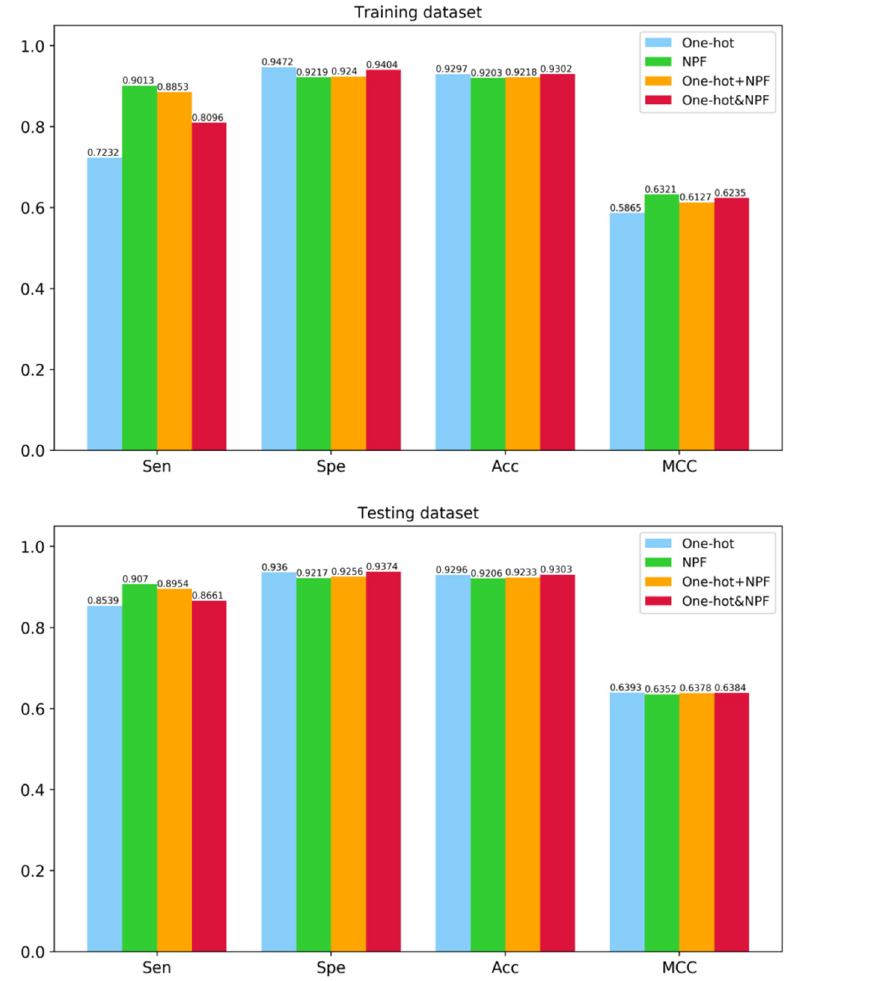
Figure 3. Performance comparison of different feature encoding methods for the prediction of 5mC sites. ( a ) Performance on the training dataset by using the 5-fold CV. ( b ) Performance on the independent testing dataset.